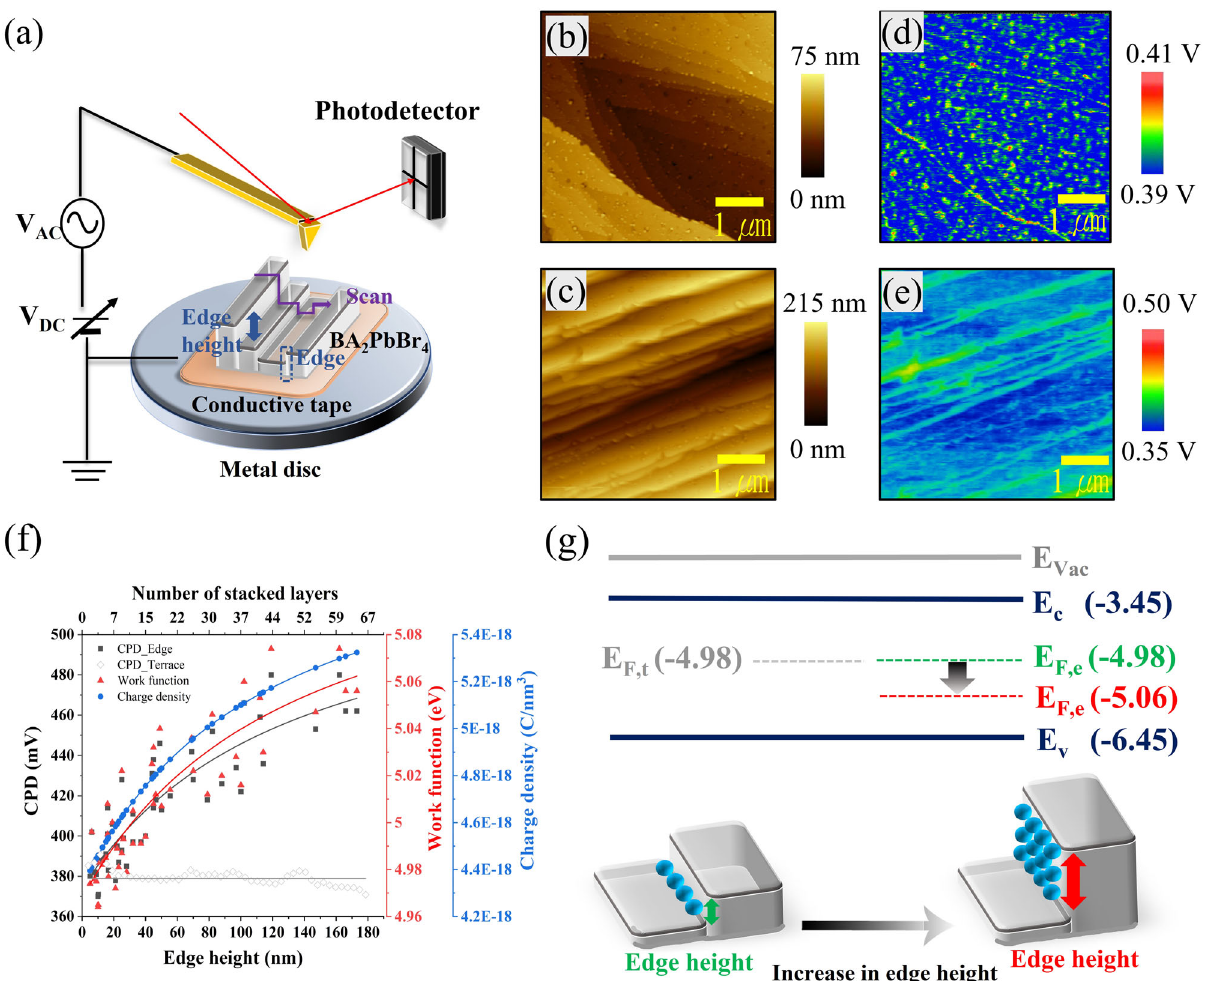
Fig. 2 Investigation of the effect of edge height through KPFM measurement. a Schematic of the KPFM measurement setup. b and c Topography images of an exfoliated BA 2 PbBr 4 single crystal measured at two different locations on the same sample, and d and e are the corresponding CPD images, respectively. f Distribution of CPD variation, work function, and charge density as a function of the edge height. CPD variation at terrace positions adjacent to the different edge heights is presented (grey diamonds) for comparison. The solid lines are a fi t to the data using an exponential function or linear function. g Energy band diagram illustrating the impact of edge height on the Fermi level ( E F,e ) position obtained from KPFM. E f,e : the Fermi level of edge, E f,t : the Fermi level of terraces, E vac : vacuum level; E C : conduction band edge; E V : valence band edge. E C and E V were determined from complementary UPS and UV – Vis